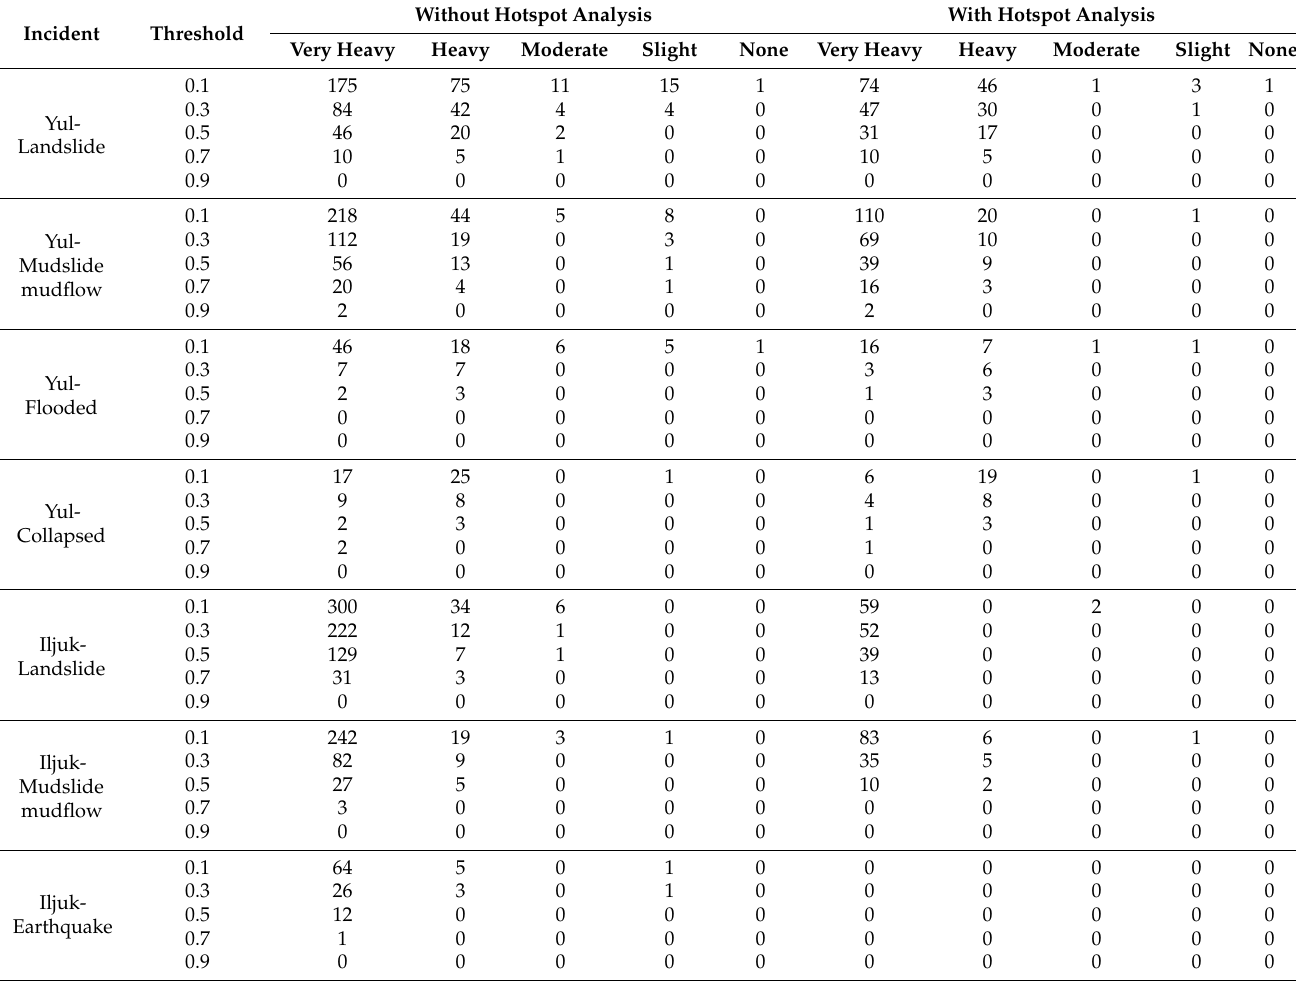
Table 4. Number of images classified by analysis (5 August